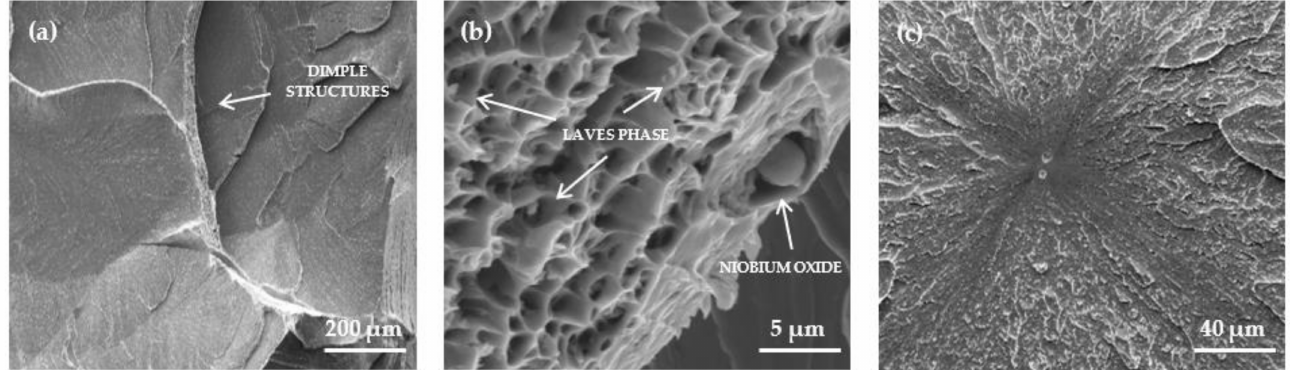
Figure 5. Representative SEM-SE micrographs of fracture surfaces from Charpy impact specimens of the model alloy Fe17Cr2.6W1Nb: ( a ) fracture surface with large cleavage planes; ( b ) dimple structures (indicating areas of ductile rupture) on the steps between the cleavage planes and ( c ) origin of